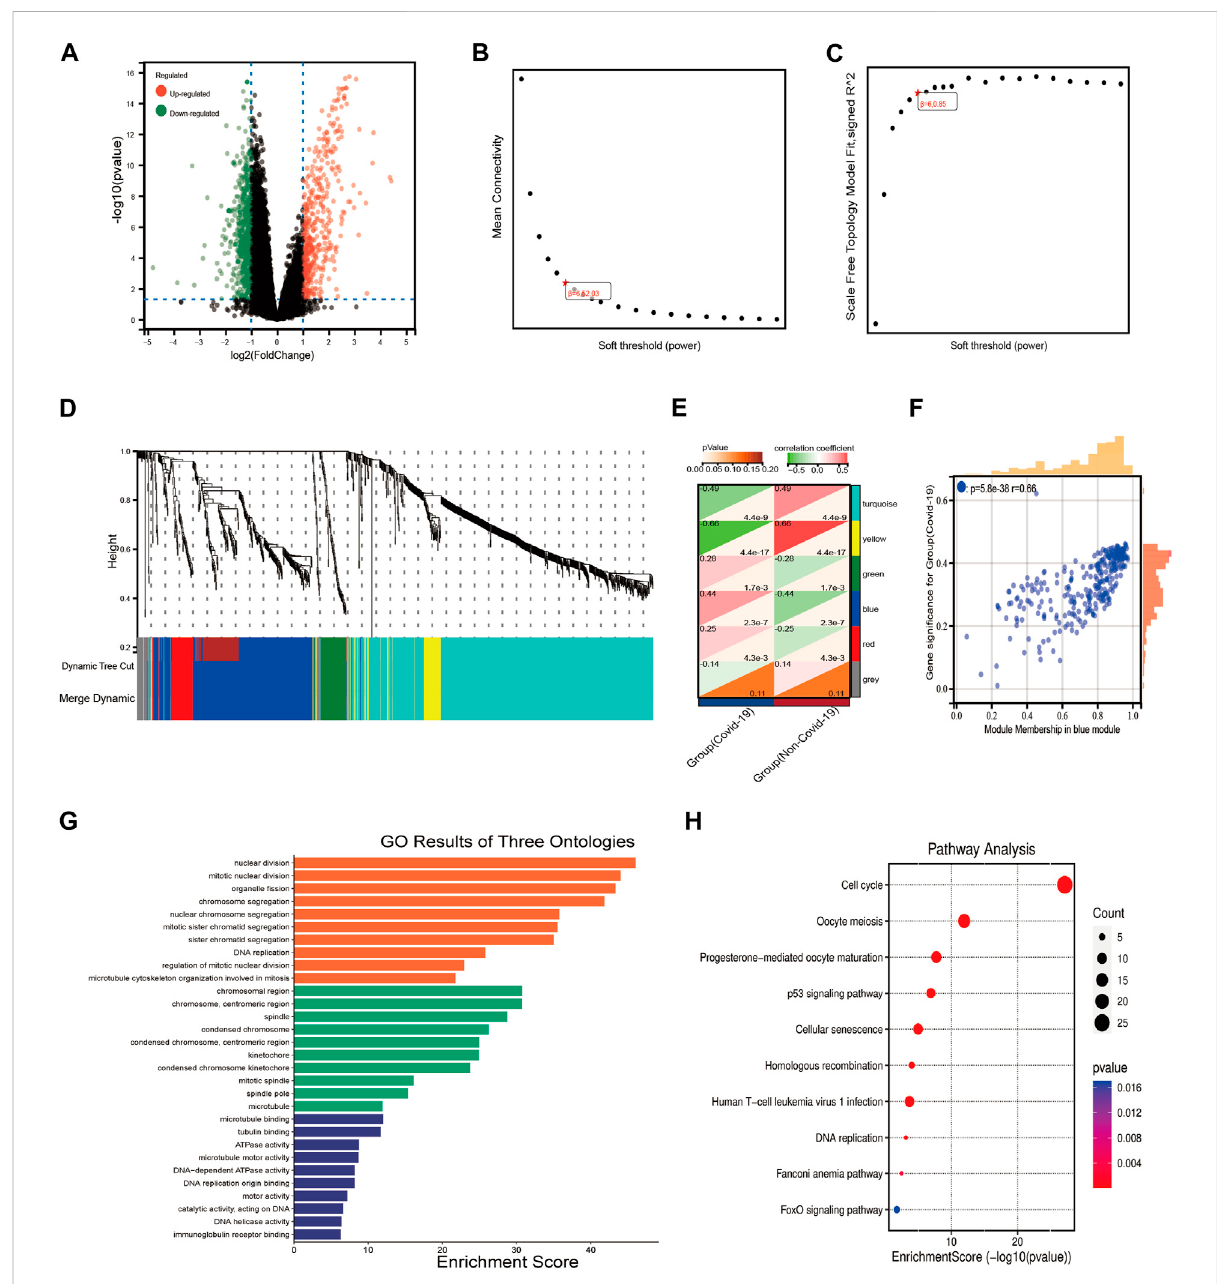
FIGURE 2 WGCNAanalysisandthefunctionalpathwayanalysis. (A) TheresultsoftheDEGsofCOVID-19. (B,C) Networktopologyanalysisofdifferentsoft threshold power. (D) Dendrograms of genes acquired by mean linkage hierarchical clustering, A color branch of the cluster tree represents a co- expression module. (E) Module-trait relationships. The red color represents positive correlation and the green color represents negative correlation. The signi fi cance of the correlation was indicated by p -value. (F) The correlation between blue module and COVID-19. (G,H) The results of GO and KEGG pathway enrichment